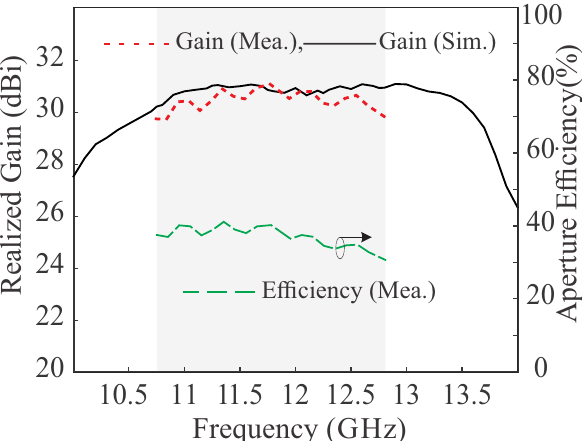
Figure 10. Simulated and measured realized gain and aperture